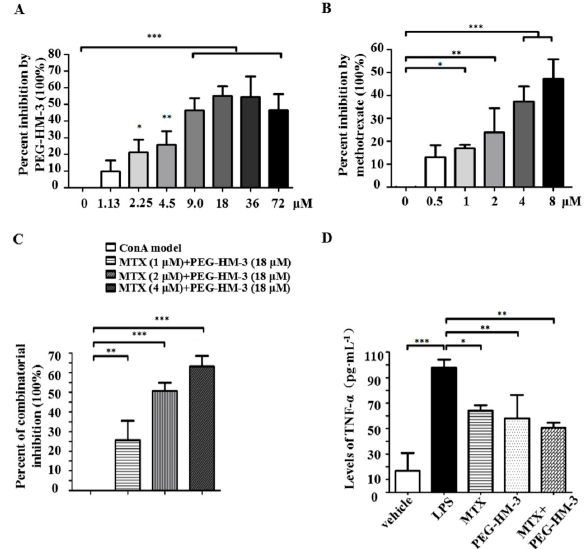
Figure 1. Effect of PEG-HM-3 alone or in combination with Methotrexate (MTX) on lymphoproliferative responses to mitogen ConA and anti-inflammation activity. ( A ) Inhibited proliferation with PEG-HM-3 (1.13–7.2 µ M) in ConA (5 µ g · mL − 1 )-induced splenocytes. ( B ) Inhibited proliferation with MTX (0.5–8 µ M) in ConA (5 µ g · mL − 1 )-induced splenocytes. ( C ) Dose-dependent inhibited proliferation with MTX in combination with fixed PEG-HM-3 (18 µ M) in ConA (5 µ g · mL − 1 )-induced splenocytes. ( D ) TNF- α levels in LPS (1 µ g · mL − 1 )-induced RAW264.7 macrophage supernatants treated by MTX (1 µ M), PEG-HM-3 (18 µ M) or their combination. Values are means and standard error of the mean (SD) ( n = 3 in ( A , B ); n = 4 in ( C ); n = 3 in ( D )). The one-way ANOVA was used for group